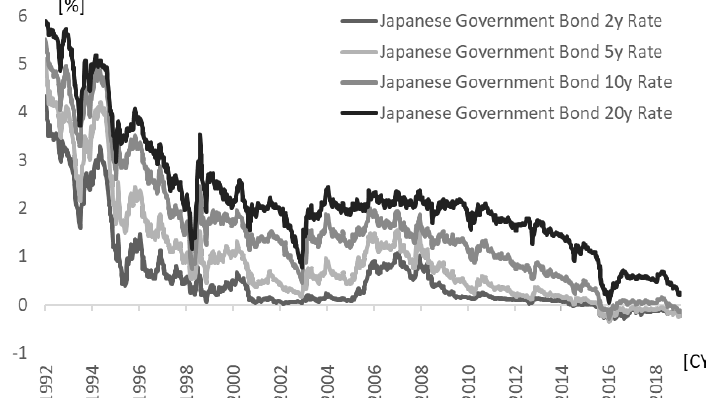
Figure 2. Historical data of Japanese government bond interest rates.